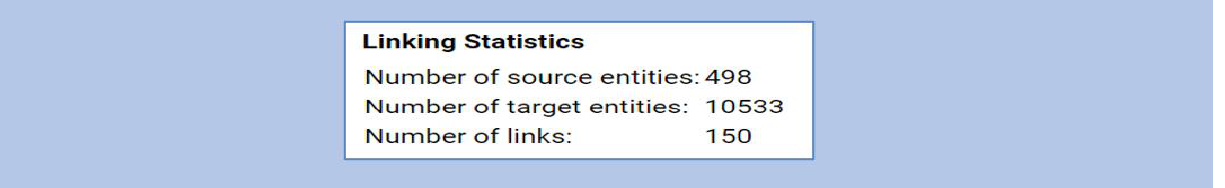
Figure 6. Part of the link results.